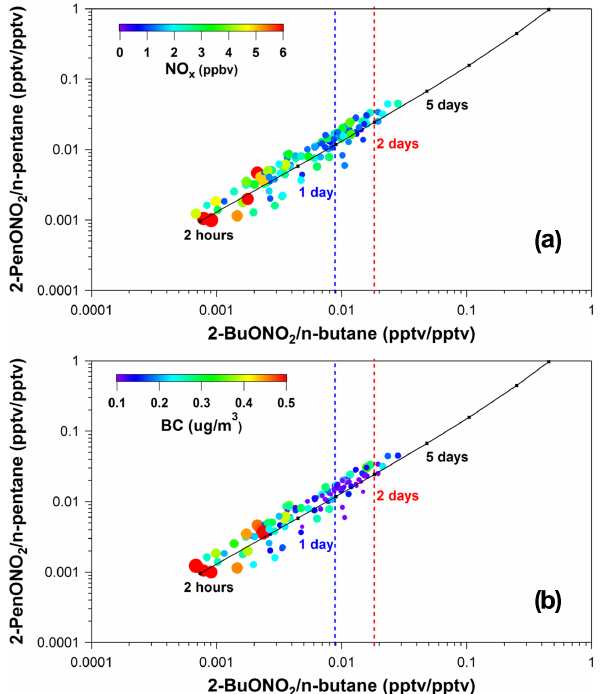
Figure 14. A photochemical clock utilizing ratios of alkyl nitrates to n-alkanes. Modeled ratios are shown as the solid line, and mea- sured data are given as points, colored and sized by daily averaged (a) NO x and (b) BC concentrations.